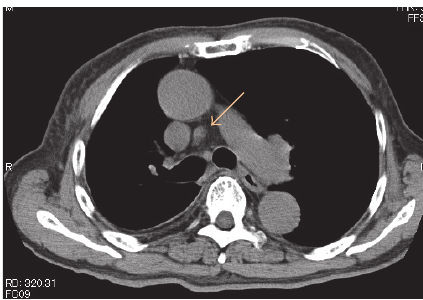
Figure 2: Mediastinum computed tomography.